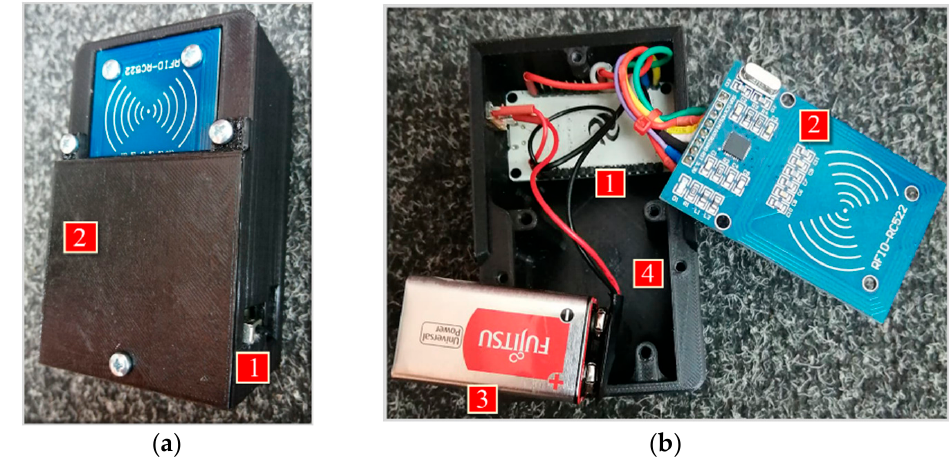
Figure 6. RFID sensor assembly ( a ) with the cover: 1) On/off switch and 2) Plastic cover ( b ) without the cover: 1) Microcontroller, 2) RFID module, 3) Power source, and 4) Plastic housing.